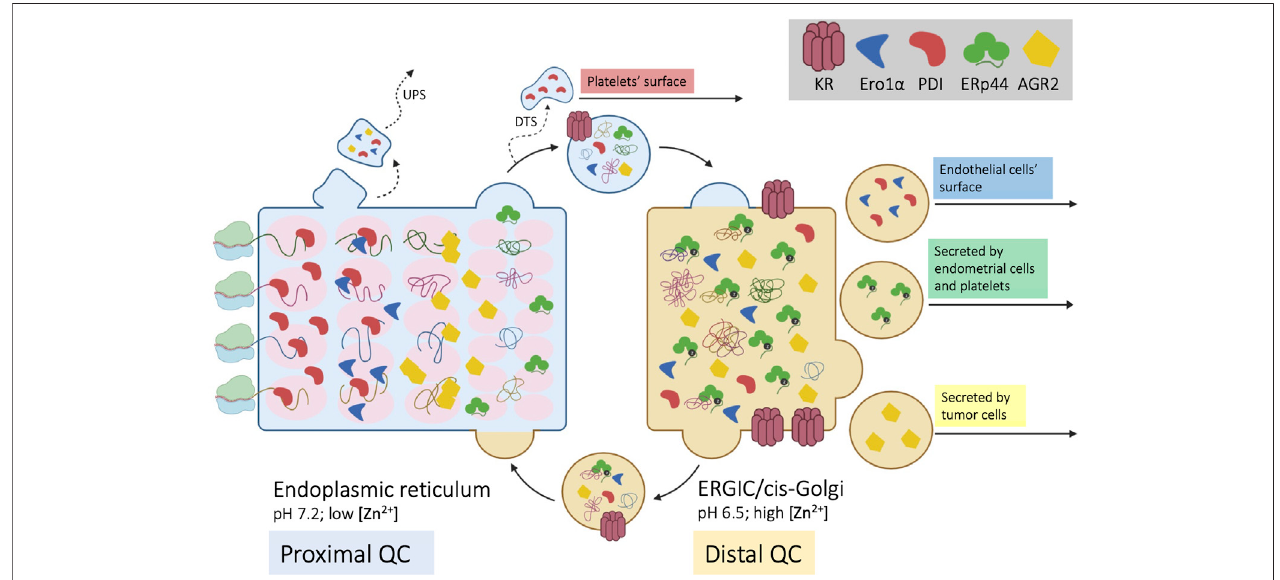
FIGURE 1 | Self-sorting of chaperones and cargoes along the early secretory compartment (ESC). Four nascent cargo proteins are depicted on the left side of the cartoon as they cotranslationally translocate into the ER. Here, they encounter a series of chaperones and enzymes, that help their folding and prevent aggregation (proximal QC). The pink ovals represent supramolecular complexes with different diffusibility, with which cargo proteins sequentially interact. Once they reach a native, compact conformation, cargoes no longer interact with the matrix and can proceed towards downstream stations of the secretory pathway. ESC residents that reach the Golgi are instead retrieved by KRs. Unlike PDI, ERp44 reaches faster the distal compartment (ERGIC/cis-Golgi) to patrol the assembly of complex, multimeric proteins (distal QC). ERp44 retrieves also Ero1 α and other enzymes that lackKDEL motifs (Prx4,ERAP1, FGE/SuMF1). Some proteins might beretro-translocated from the ERtothe cytosol and exported via unconventionalpathways ofsecretion (UPS).As shown in theright part ofthe cartoon, some ESC residents elude KRs ’ retention/ retrieval and are foundalso extracellularly.During megakaryocyte maturation, PDI isrouted towardssmoothER fragments called “ dense tubularsystem ” (DTS). PDIand Ero1 α are also found on the surface of endothelial cells, whilst ERp44 is secreted during decidualization of primary endometrial cells. AGR2 is instead abundantly secreted by tumor cells or upon in fl ammation.